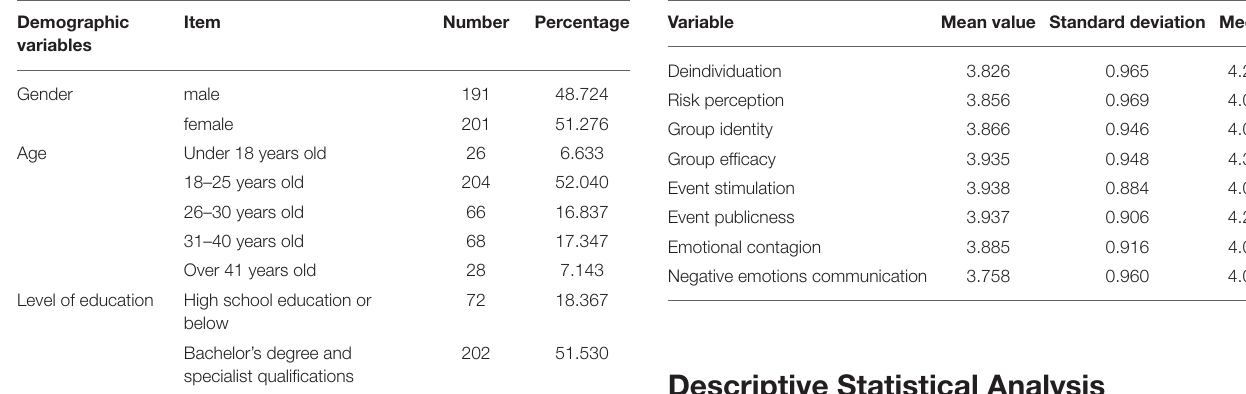
TABLE 4 | Descriptive statistical analysis of each